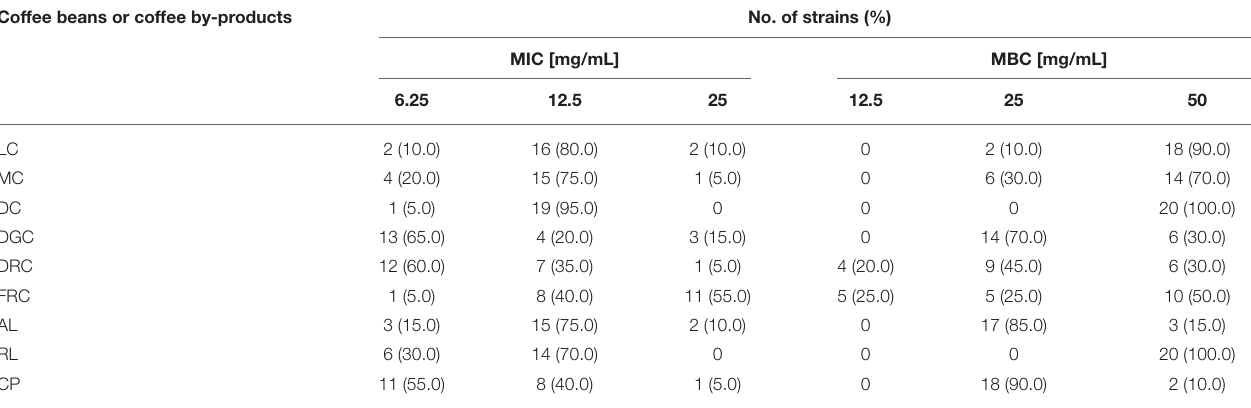
TABLE 3 | The susceptibility of a total of 20 V. cholerae clinical strains to the extracts of coffee beans and coffee by-products. Coffee beans or coffee